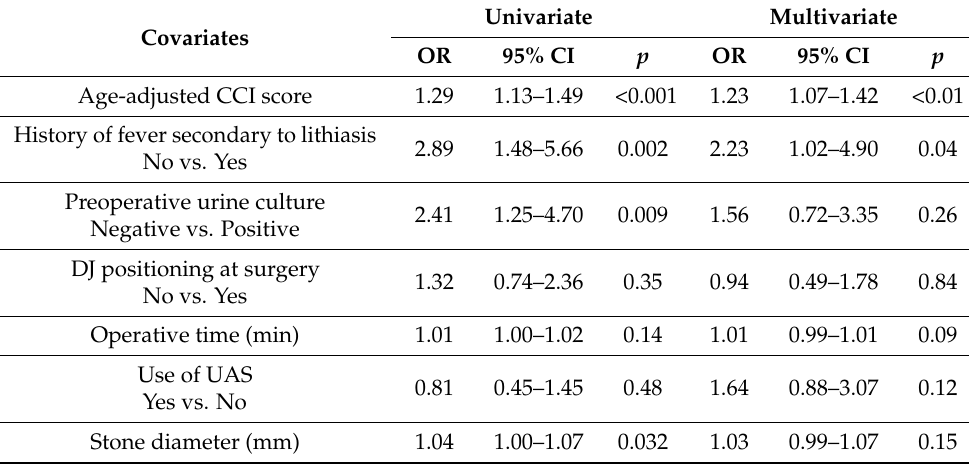
Table 3. Univariable and multivariable logistic regression analyses predicting postoperative fever.